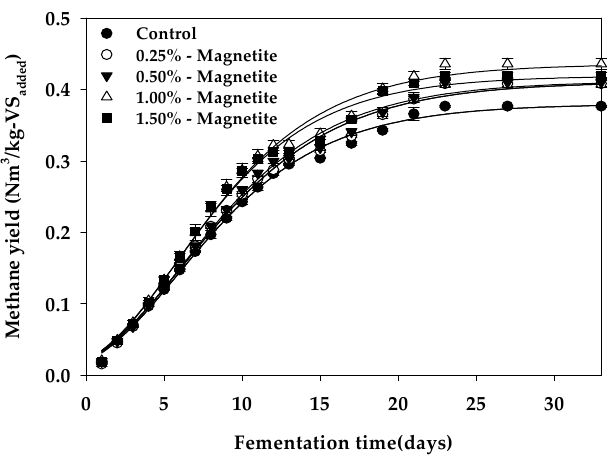
Figure 2. Methane yield curves optimized by the modified Gompertz model for the addition of different concentrations of magnetite (Fe 3 O 4 ).